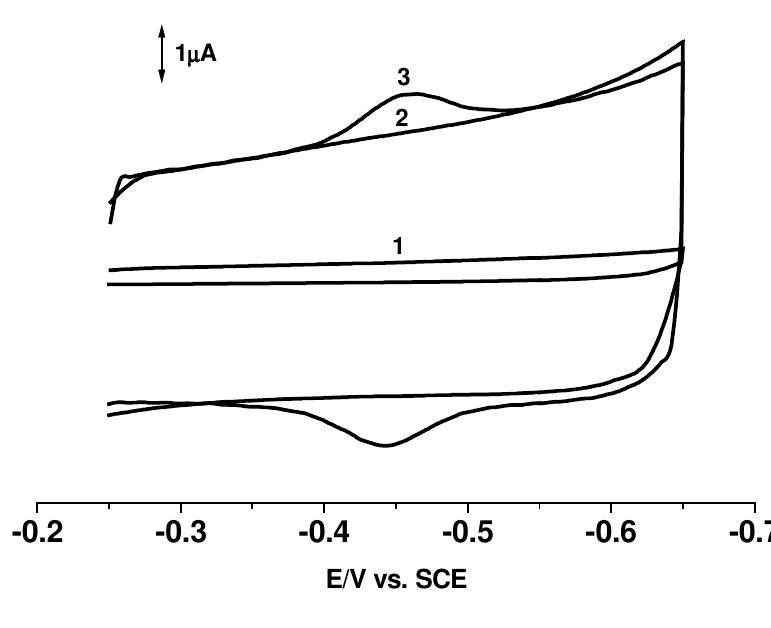
Fig.1. Cyclic voltammograms of glucose oxidase (1.0 ×10 -4 M) at a bare gold electrode (1) and a SWNT-modified glod electrode (3). Curve (2) is a voltammogram acquired at a SWNT-modified gold electrode in the absence of glucose oxidase. The electrolyte solution used was a 0.05M phosphate buffer (pH 7.0) and the scan rate employed was 0.1Vs -1